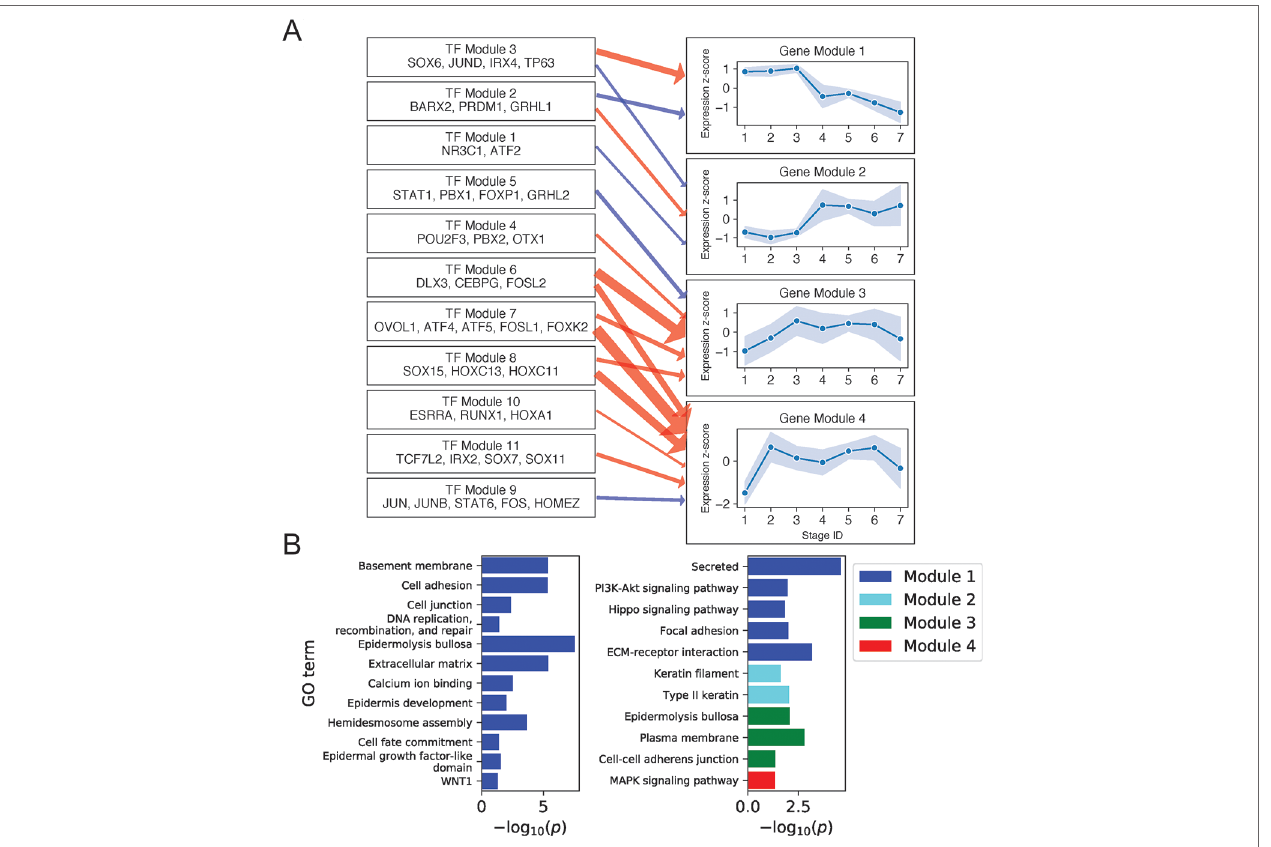
FIGURE 3 | Basal keratinocyte network analysis identifies gene and TF modules specific to basal functions. (A) Regulation of four GO-enriched gene modules by TF modules, represented as a directed graph. Gene module nodes show log-transformed stage-wise mean imputed expression normalized across stages 1 to 7 with shading of 1 standard deviation interval. Transcription factor modules list their TF constituents. Arrows indicate regulation with width proportional to predicted strength of activation (red) or inhibition (blue). (B) Minus log of adjusted p values for selected GO terms enriched in each gene module. See also Supplementary File 1: Figure S5